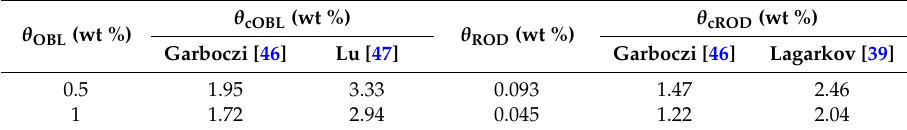
Table 3. Percolation thresholds of composites filled either with oblate ellipsoids at different concentrations in wt % ( θ OBL ) or with cylindrical rods at different concentrations in wt % ( θ ROD ), having the geometrical dimensions reported in Table 1.